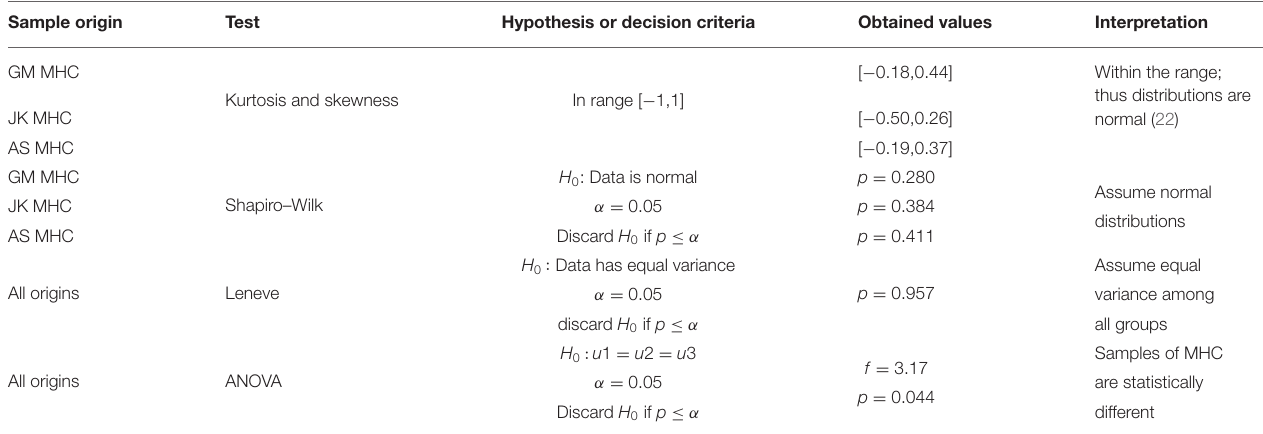
TABLE 2 | Statistical analysis on samples of MHC obtained manually by three